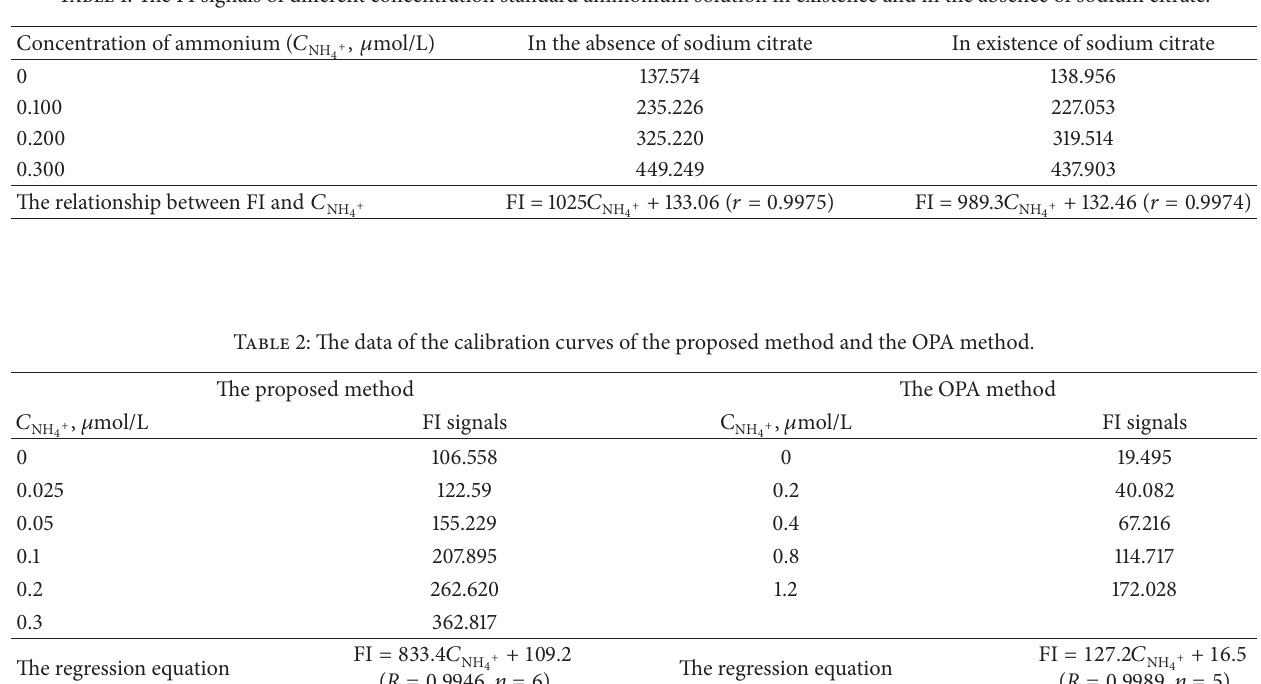
Table 1: The FI signals of different concentration standard ammonium solution in existence and in the absence of sodium citrate.